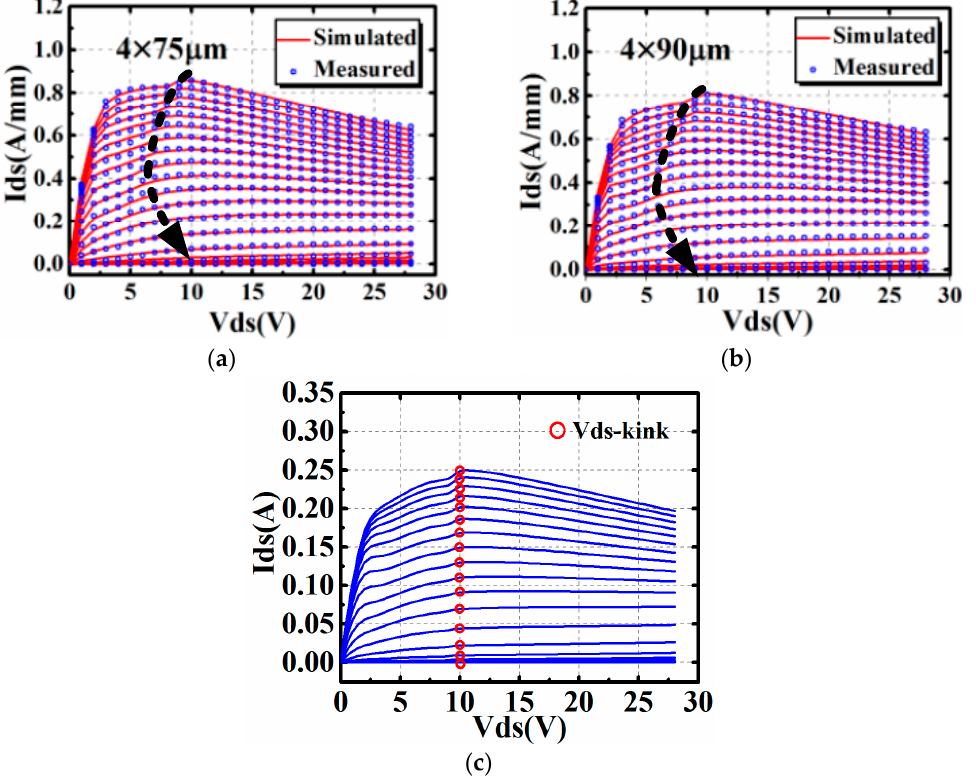
Figure 4. Validation of DCIV characteristics of the proposed model: ( a ) 4 × 75 µ m GaN HEMT, ( b ) 4 × 90 µ m GaN HEMT and ( c ) Results of the modeling approach in [25].